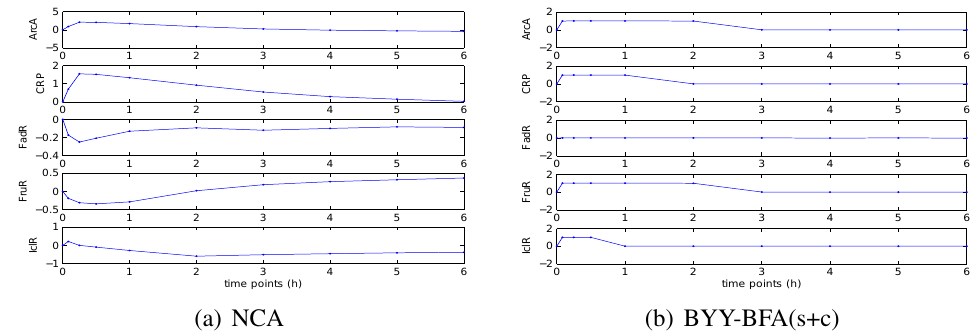
Figure 3: The estimated TFA profiles on E.Coli data: (a) by NCA with MSE 0 . 0117 ; (b) by BYY- BFA(s+c) with MSE 0 . 02213